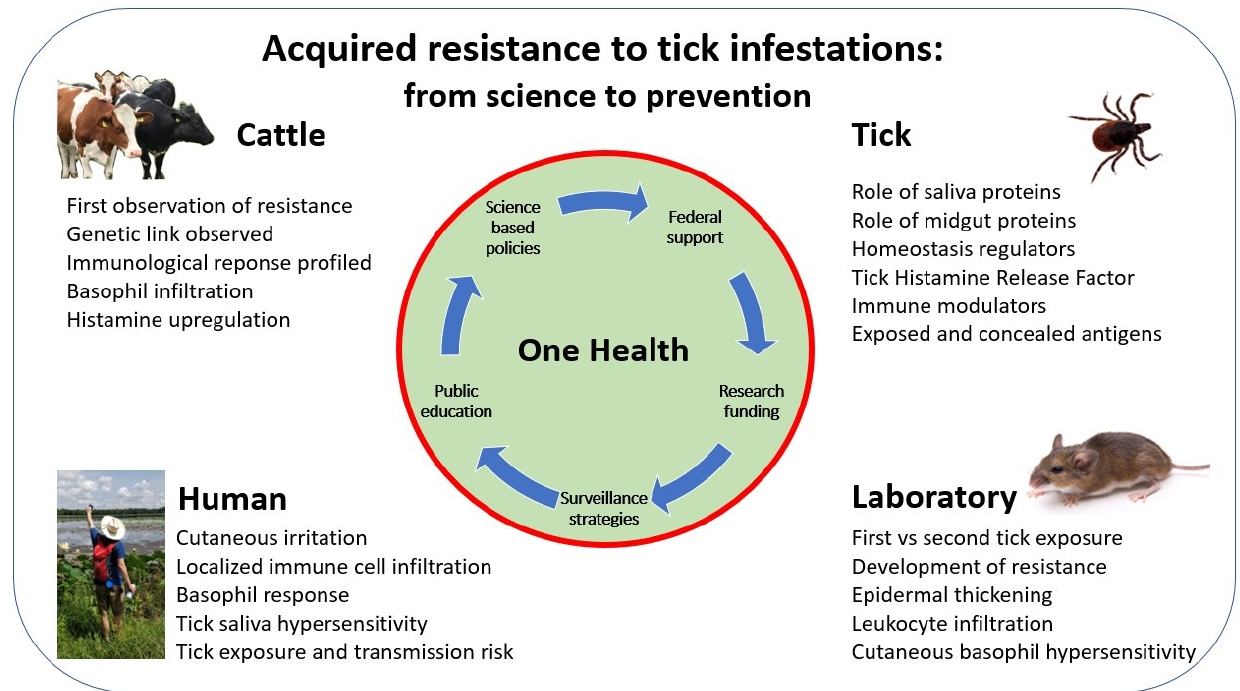
Figure 1. Acquired resistance to tick infestations: from science to prevention. A multidisciplinary, or One Health approach to understanding the immunological basis for acquired resistance to tick infestations. Historical data starting with the early reports on acquired resistance in cattle in 1899, to laboratory trials and human data. Our understanding of acquired resistance to tick infestations has increased substantially, both from the tick as well as from the host perspective. To bring this knowledge into successful interventions, a One Health collaborative approach between research institutions, industry, federal government, educational groups, and policy makers is required.